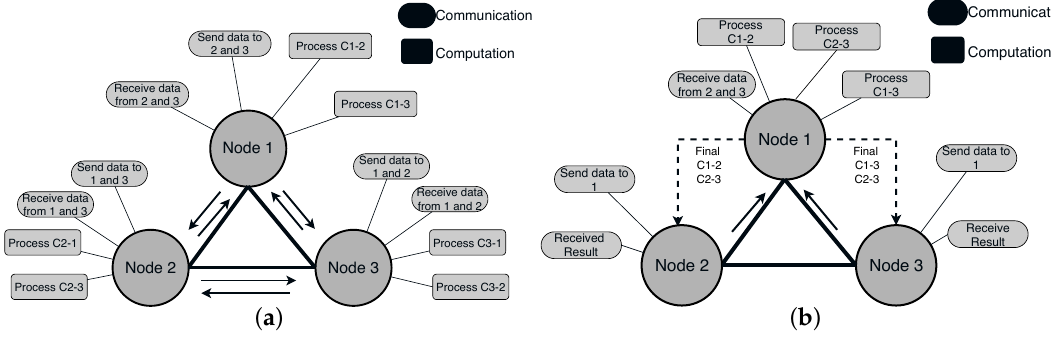
Figure 4. ( a ) Current communication pattern; and ( b ) proposed communication-reduced method example.